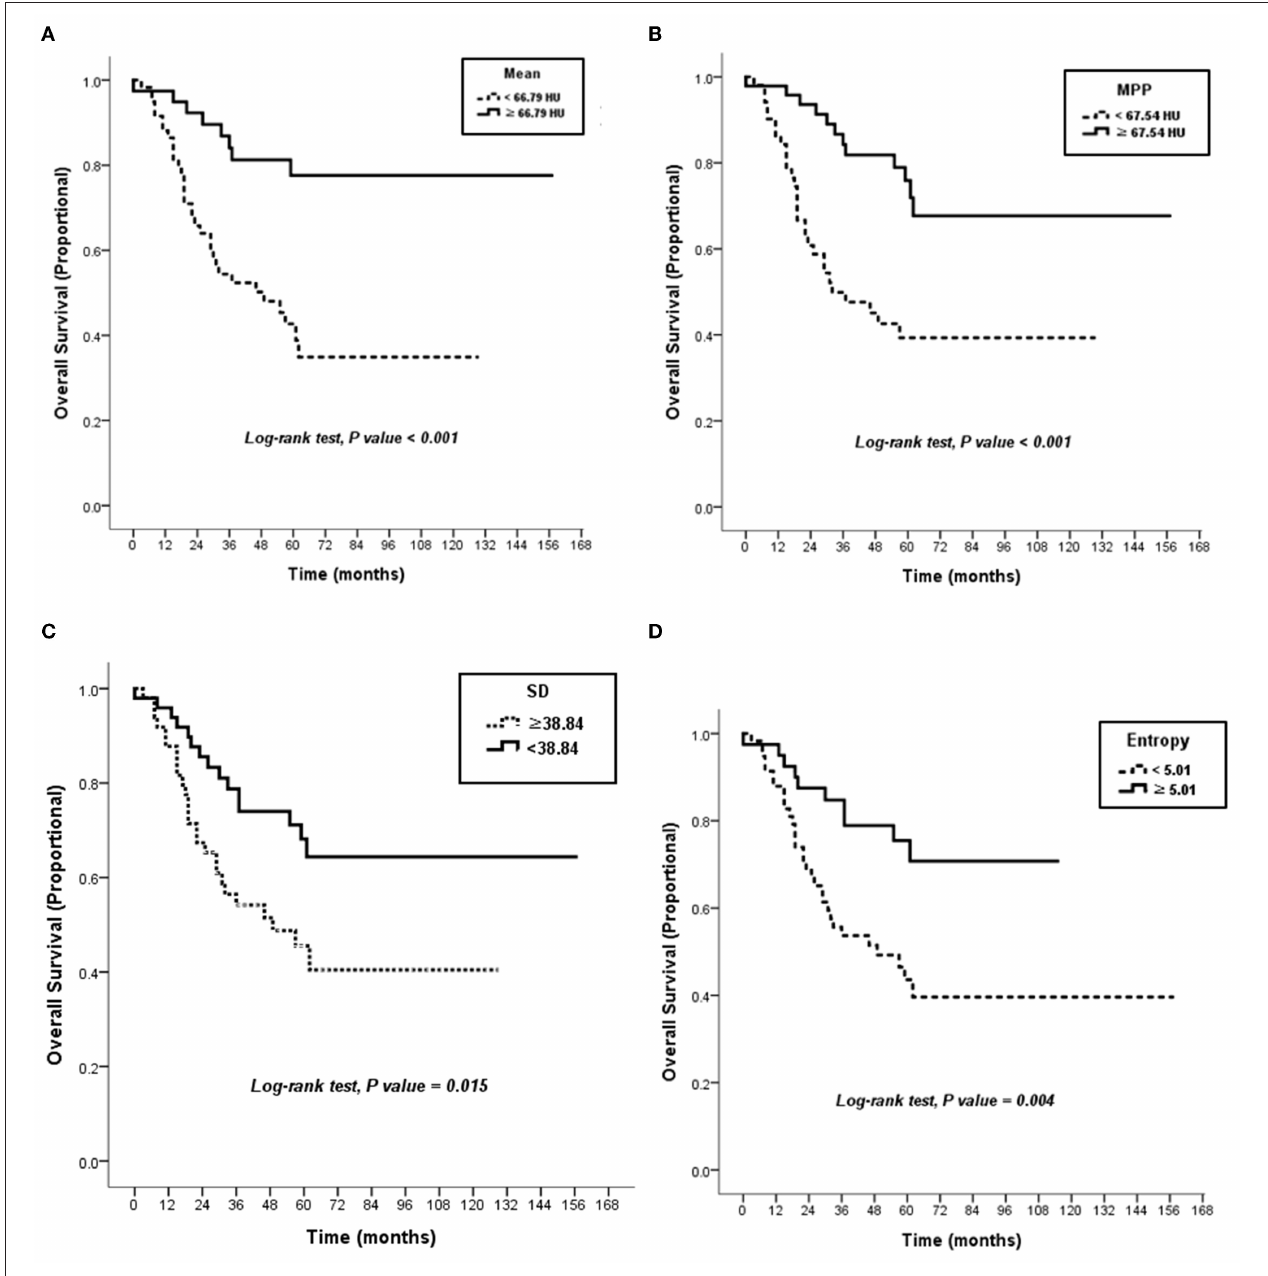
FIGURE 4 | Kaplan–Meier curves. There were significant differences in overall survival according to attenuation of 66.79 HU in mean on post-contrast the CT image ( P < 0.001) (A) , attenuation of 67.54 HU in MPP on the CT image ( P < 0.001) (B) , SD of 38.84 on the CT image ( P = 0.015) (C) , and 5.01 in entropy on the CT image ( P = 0.004) (D) . HU, Hounsfield units; MPP, mean of positive pixels; SD, standard